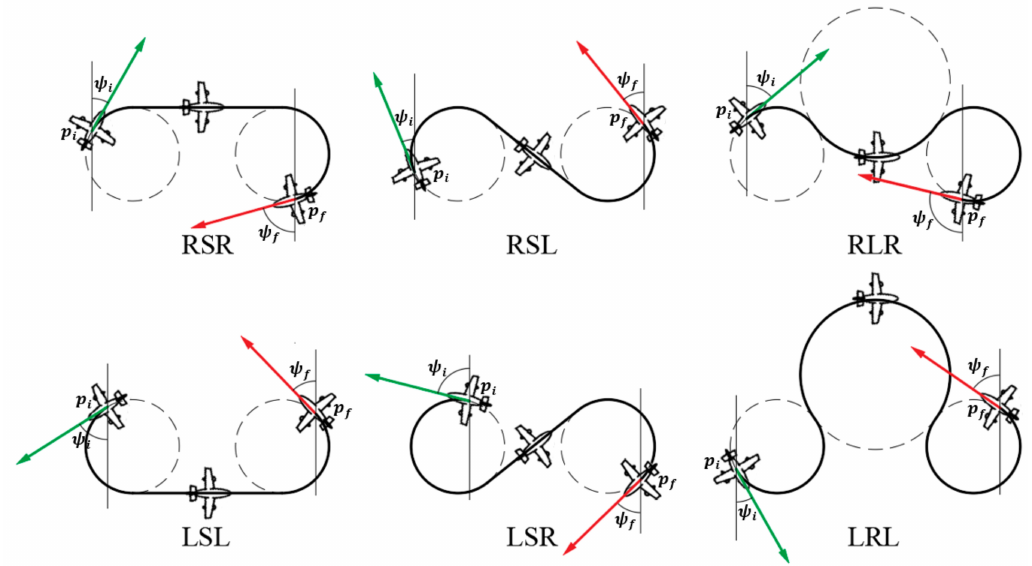
Figure 3. Classification of Dubins